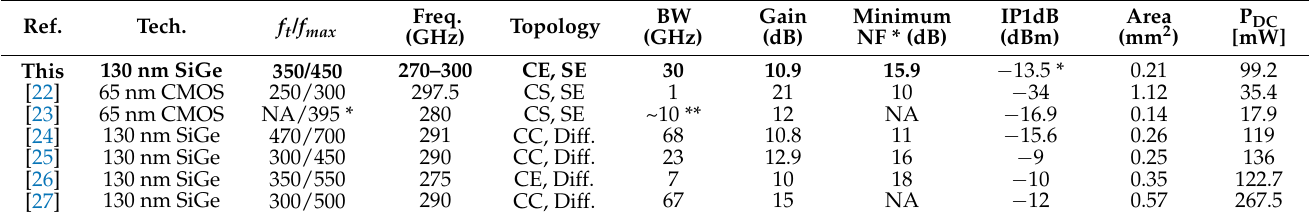
Table 1. Summary of State-Of-Art Amplifiers Around 280